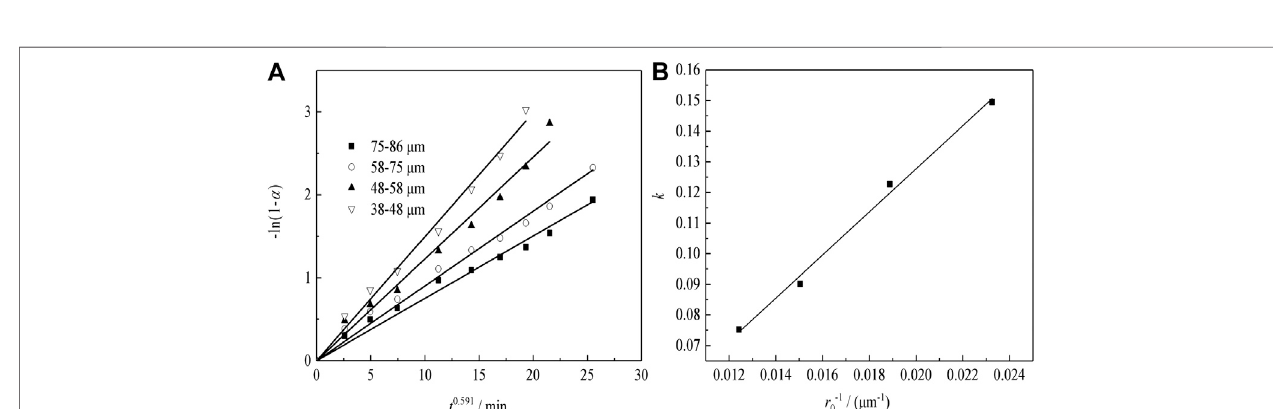
FIGURE 11 | Transformation ratio of Nd and kinetic analysis with various temperatures.